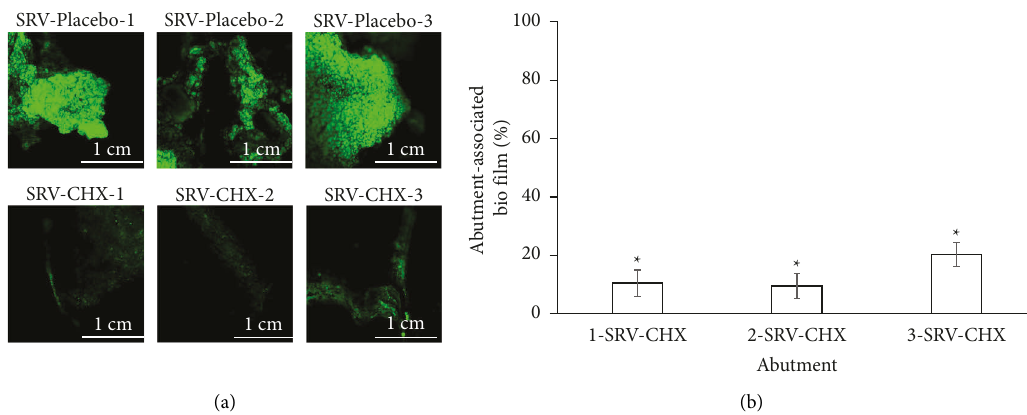
Figure 3: CLSM images of abutment-associated biofilm. S. mutans were incubated with sucrose on the SRV-placebo/CHX-coated abutments in order to form biofilms. Cells in biofilms formed on the abutments were examined after 13 days of exposing the abutments to S. mutans using a CLSM after staining with SYTO 9 (green fluorescence). (a) Upper panel: SRV-placebo-coated abutments, 1, 2, and 3; lower panel: SRV-CHX-coated abutments, 1, 2, and 3. Magnification × 40. (b) Quantitative analysis of biofilm formation on SRV-CHX-coated abutments. ∗ Significantly lower than the SRV-placebo ( P < 0 . 05).